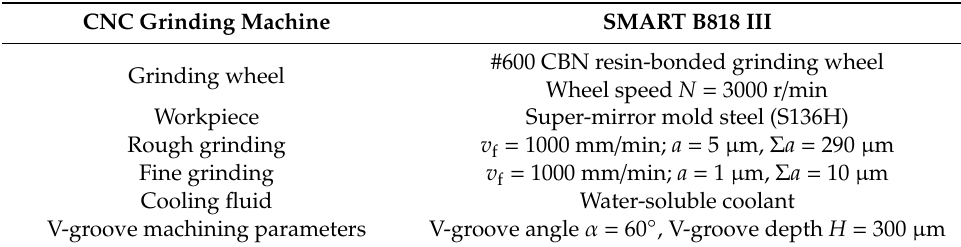
Table 2. The precision grinding conditions of the micro-structured mold core.